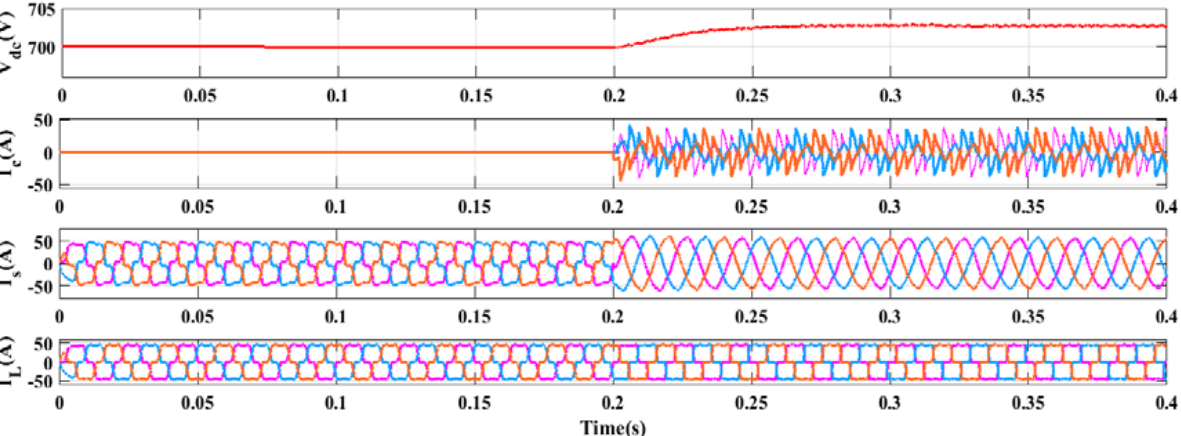
Figure 19. The behavior of enhanced SRF SOGI-FLL-based DSTATCOM under current source-based non-linear load.